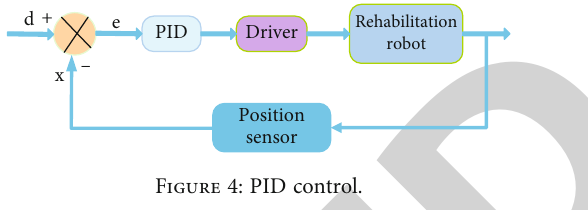
Figure 3: Self-organizing network structure diagram.